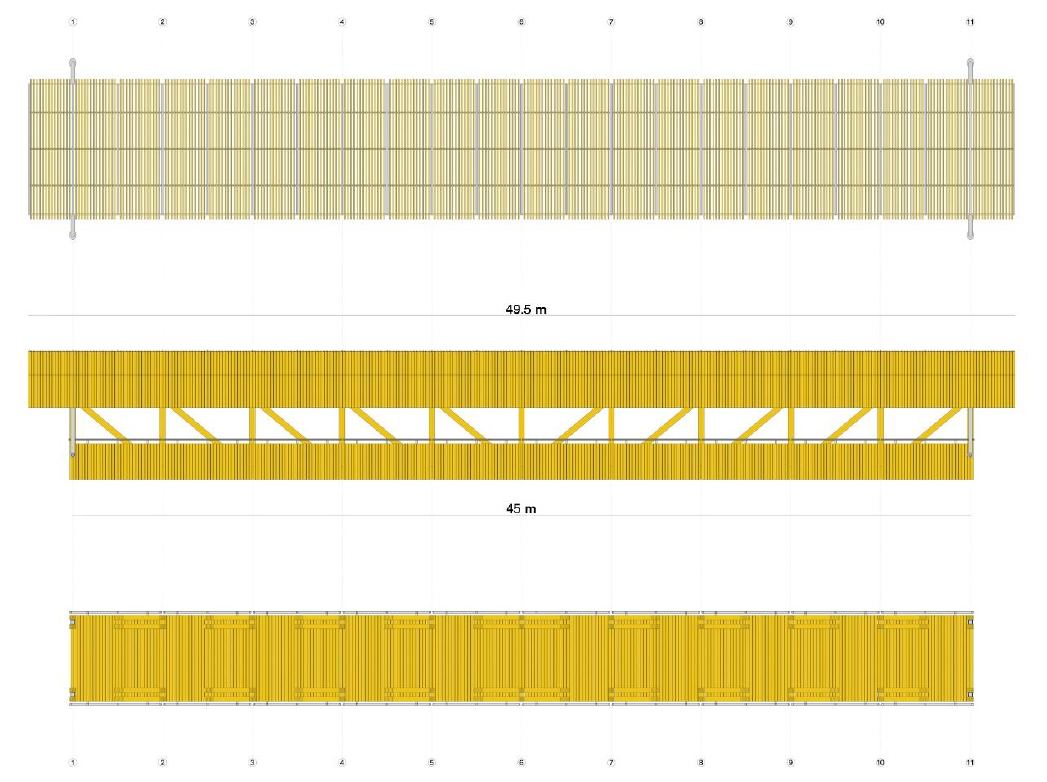
Figure 5. Final longitudinal profile chosen for the bridge.